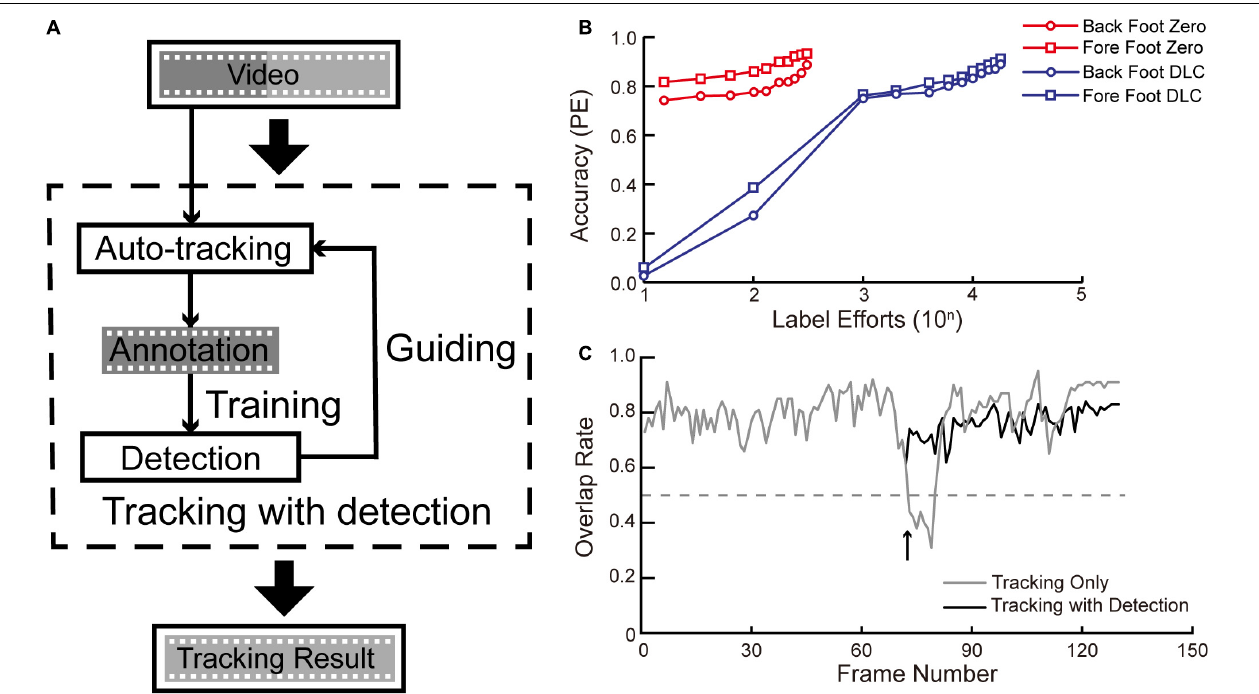
FIGURE 5 | Tracking with detection mode. (A) In the tracking with detection mode, a video can be tracked by the auto-tracking mode first, as described above. Then the detection module can be trained by these annotation results and help improve the automatic tracking with higher accuracy. Iteratively, it is possible to track a long video stably with the well-trained detection module. We set the threshold at 0.3 for output confidence activating the detection module to avoid compromising processing speed. (B) The comparison of labeling efforts between the tracking with detection mode of SNAP-Tracker (red) and DLC (blue). The accuracy of DLC is positively related to the number of training images, which requires manual annotation. While for the detection module of SNAP-Tracker, the primary tracking module can provide most annotations, achieving similar accuracy with fewer human laborious by almost two magnitudes. Accuracy: the ratio of frames with PE value lower than the threshold of 20 pixels. (C) An example of autocorrection by the detection module. The tracking with detection mode can (the black line) prevent failures that happen in the tracking-only mode (the gray line). X -axis: Frame number of the video; Y -axis: overlap rate with the evaluation threshold of